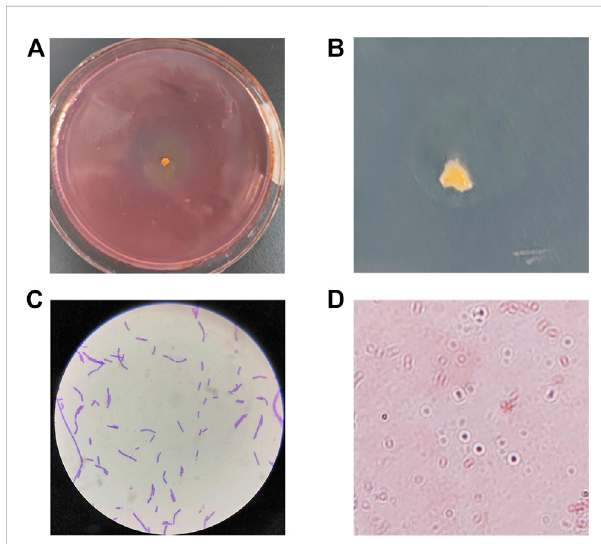
FIGURE 1 Morphological identi fi cation and staining results of Bacillus cereus ZWT-08. (A) Ayellowchromogeniccircleappearedaroundthe ZWT-08 in the selective chitin plates, whose shade represents the CDA-producing capacity of the strain. (B) Single colony morphology of ZWT-08 in the chitin plates indicated it to be an irregular colony, soft texture, molten wax-like, and no pigment. (C) Gram staining results were positive. (D) The spore staining was